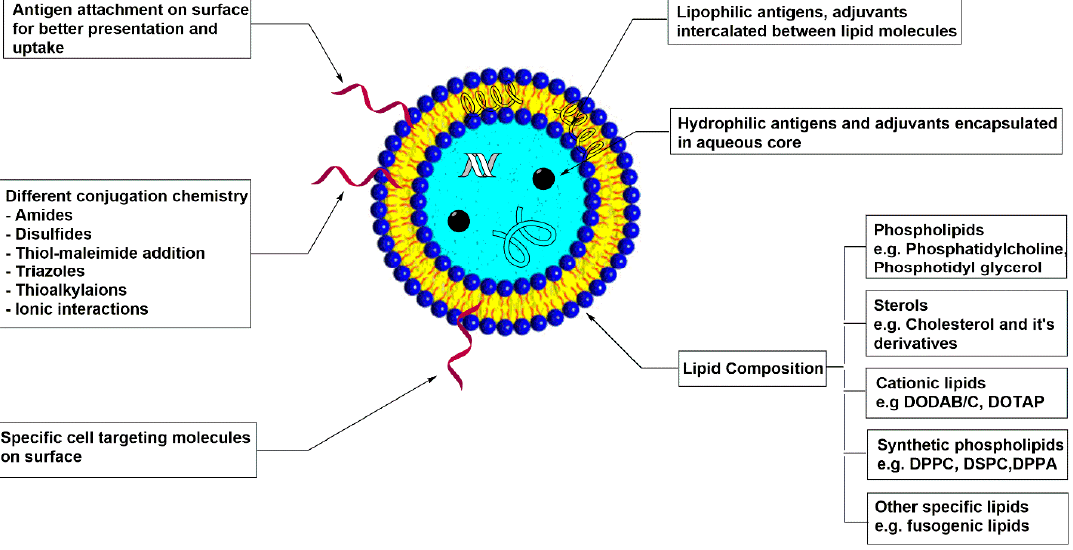
Figure 1. Variations with liposomal vaccine delivery system.